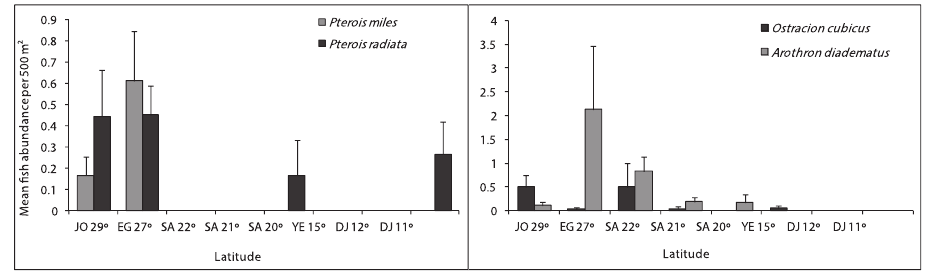
Figure 6. Differences in mean fish abundance per 500 m² transect according to latitudinal distribution for the fish species belonging to the family Scorpaeinidae ( P. miles, P. radiata ), Ostraciidae ( O. cubicus ), and Tetraodontidae ( A. diadematus